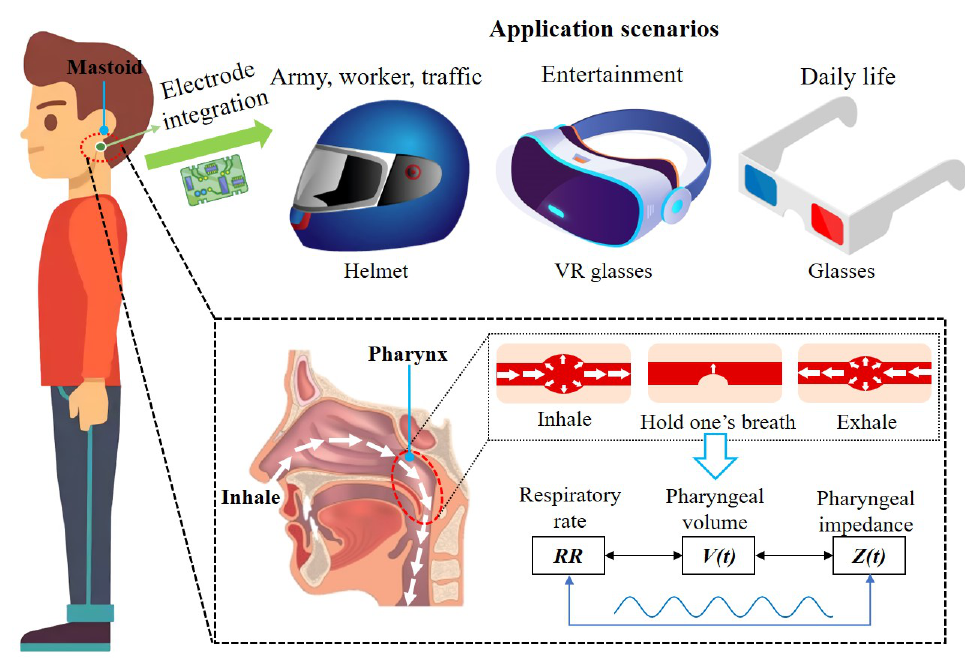
Figure 1. Head-mounted respiratory monitoring